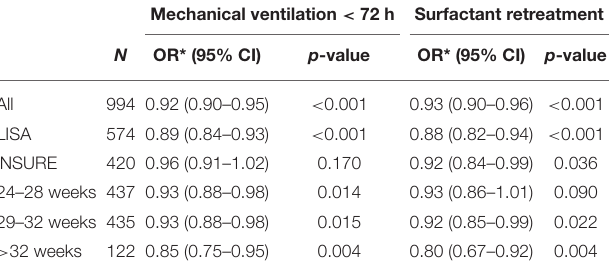
TABLE 3 | ORs for poractant alfa as a continuous covariate in the multiple logistic regression models evaluating subgroups; the remaining covariates were sex,